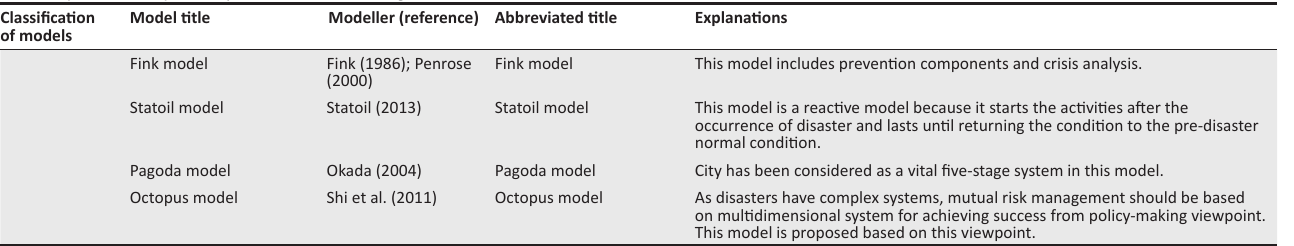
ExplanationsAbbreviated titleModeller (reference)Model titleClassification